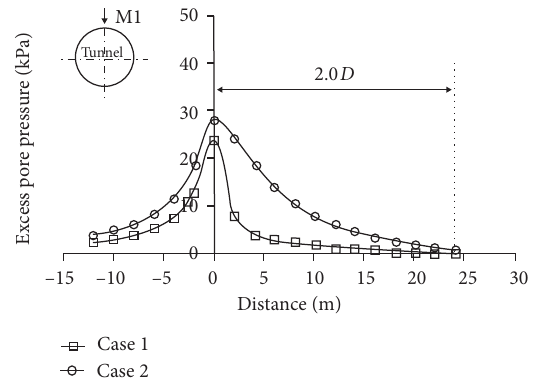
Figure 12: Distribution of excess pore water pressure under dif- ferent permeability